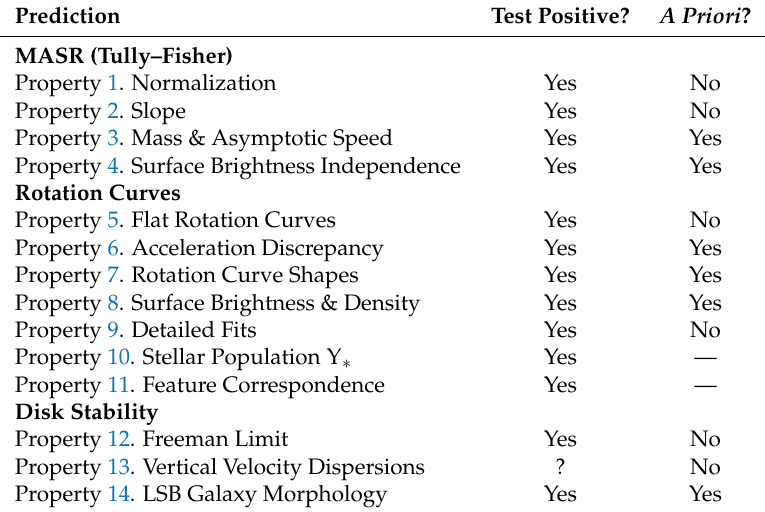
Table 1. MOND Predictions and